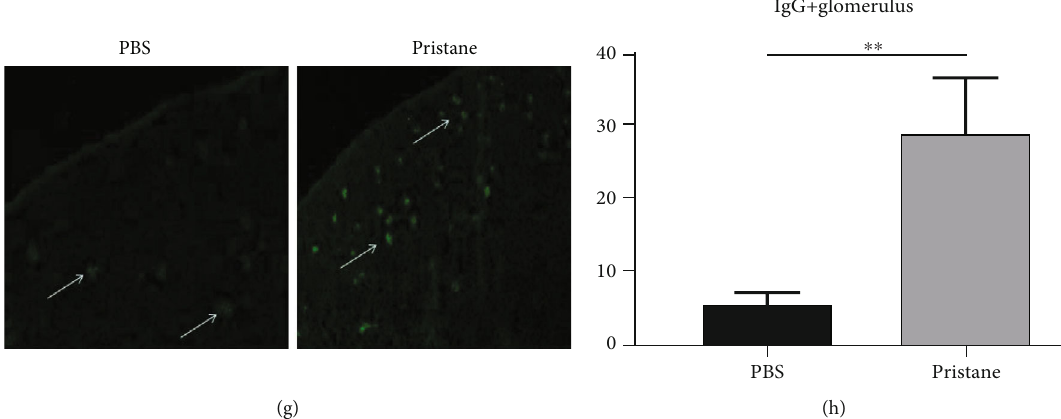
Figure 1: Serum immunoglobulin levels in pristane-induced lupus-like mice. Sera were collected before the injection and at 6 months post- PBS or pristane treatment. The levels of total IgG (a), total IgM (b), IgG2a (c), and anti-P0 (d), anti-SnRNP (e), and anti-dsDNA (f) autoantibodies in the serum were determined by an ELISA assay. Furthermore, the kidneys were collected when the mice were sacri fi ced at 6 months after PBS/pristane injection. The deposition of immune complexes (g) in the kidney was detected by the immuno fl uorescence assay. (h) Statistic analysis of immune complexes in the kidneys. Data were pooled from three independent experiments with 5 mice per group in each experiment. ∗ p < 0 : 05 ; ∗∗ p < 0 : 01 ; ∗∗∗ p < 0 : 001 ; ∗∗∗∗ p < 0 : 0001 .